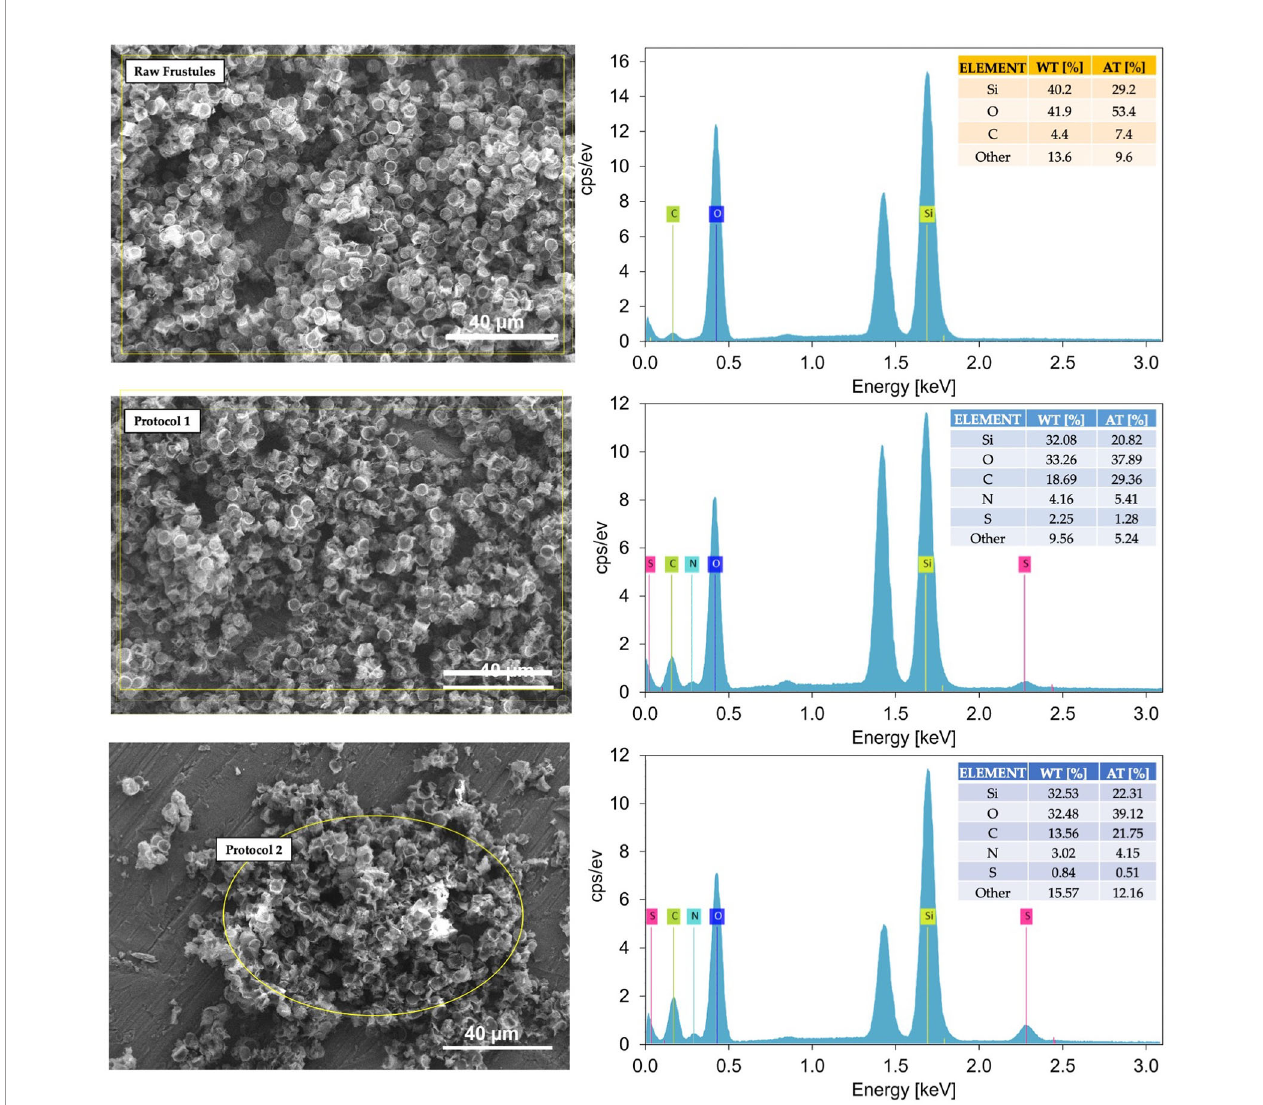
FIGURE 5 | Representative SEM-EDS spectra of raw and functionalized frustules using Protocol 1 and Protocol 2 . At 1.5 keV the aluminium signal arising from the support used for samples deposition